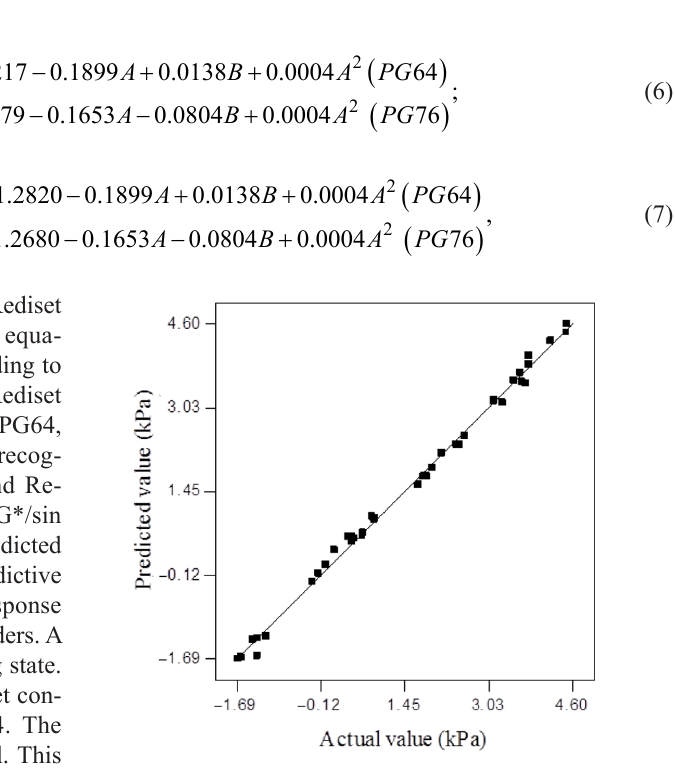
Fig. 5. Predicted and actual values of Ln(G*/sin